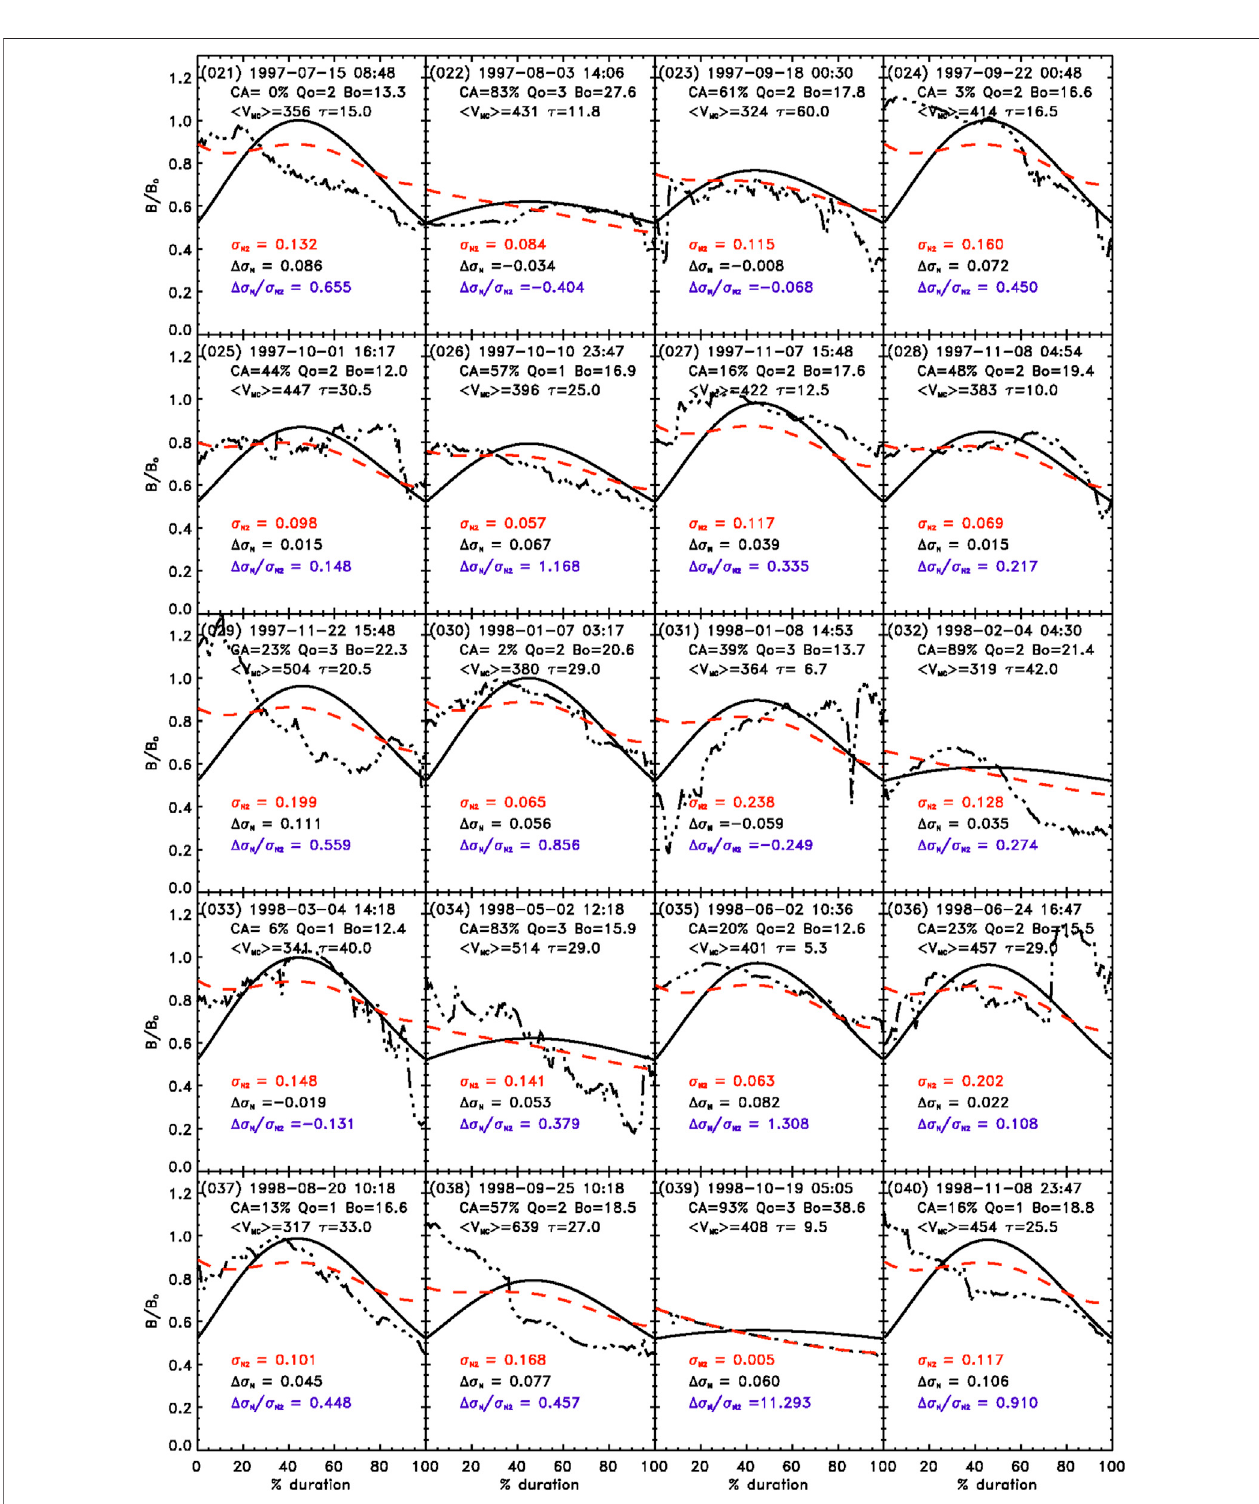
FIGURE3| Examplepage(p.2)ofsetof11pages(20panelseach)ofthesamequantitiesasshownin Figure1 ,andinthesameformat,of Wind MCsfromlaunch to July of 2015.